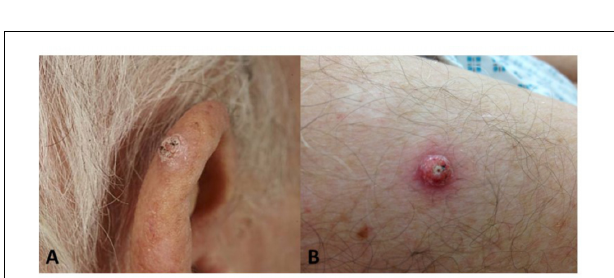
FIGURE 2 | Cutaneous squamous cell carcinomas developing after BRAFi exposure. (A) Well-differentiated SCC on the ear of patient 1; (B) Lesion V4, well-differentiated SCC on the arm of patient